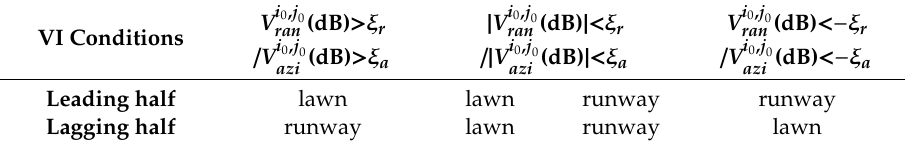
Table 1. VI conditions and the corresponding surface cases within the reference window.